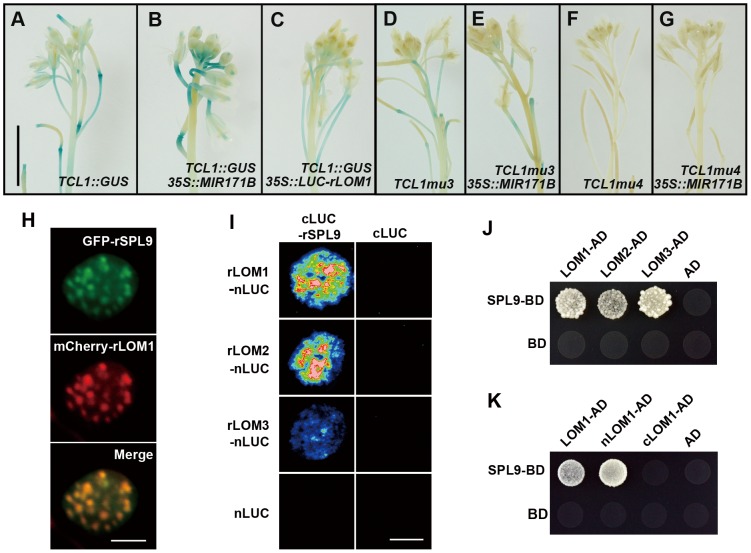
LOMs repress SPL function through direct protein-protein interaction.(A–C) TCL1::GUS reporter in indicated backgrounds. GUS activity was increased in MIR171BOE (B) and decreased in LUC-rLOM1OE (C) compared to wild-type (A) inflorescences. (D–G) The increase of GUS activity in MIR171BOE plants was abolished when the SPL binding sites in TCL1 promoter was mutated (see [23]). MIR171BOE did not increase the activity of TCL1mu3::GUS (E) and TCL1mu4::GUS (G), compared to that shown in (D) and (F), respectively. Scale bar in (A) represents 1 cm for (A–G). (H) SPL9 and LOM1 were co-localized in nucleus. 35S::GFP-rSPL9 and 35S::mCherry-rLOM1 were transiently expressed in N. benthamiana leaves and the fluorescence merged in nucleus. Scale bar, 10 µm. (I) BiFC assay of the interaction between LOMs and SPL9. rLOMs-nLUC or nLUC was transiently co-expressed with cLUC-rSPL9 or cLUC in N. benthamiana leaves; only the combination of rLOMs-nLUC and cLUC-rSPL9 triggered the luciferase activity when luciferin was infiltrated. Scale bar, 1 cm. (J) Yeast two-hybrid assay of protein-protein interaction. SPL9-BD combined with LOM1/2/3-AD conferred yeast growth in -Leu-Trp-His medium. (K) SPL9 interacts with the N-terminal (1–250) of LOM1 (nLOM1) in yeast two-hybrid system.